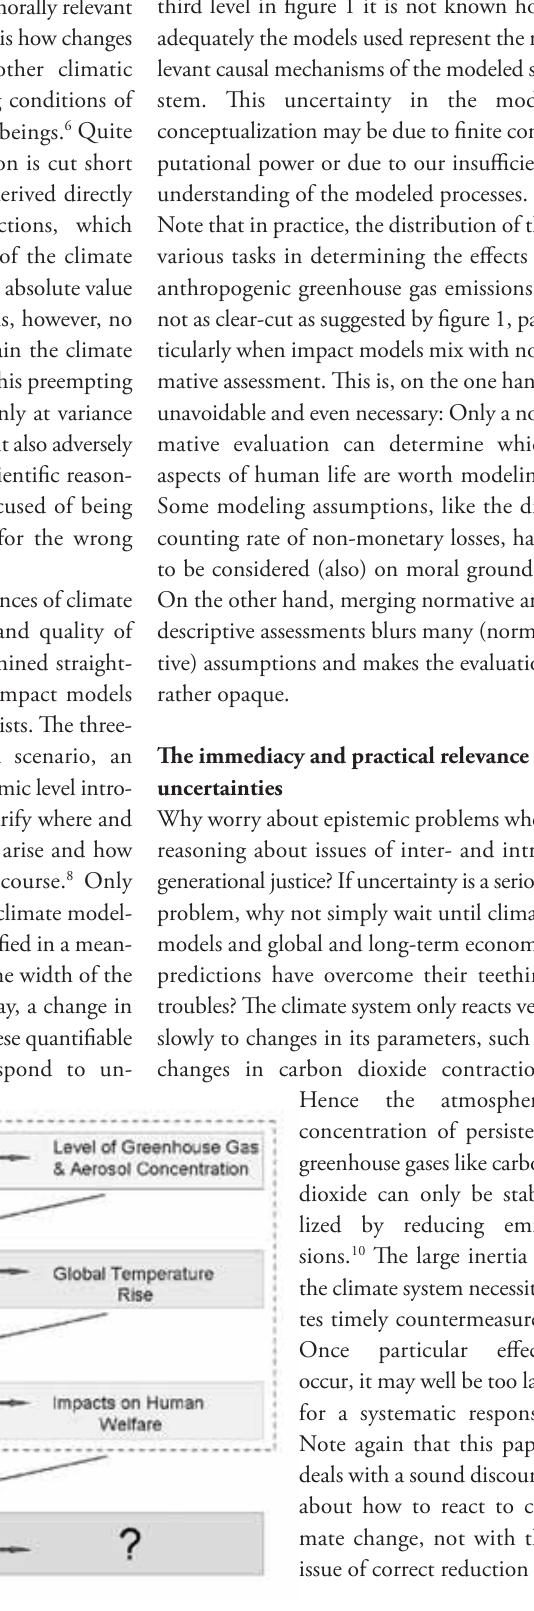
Figure 1: ‘Estimating the impacts of greenhouse gas emissions on human wellbeing.’ Short straight double arrows correspond to 'yields the output', long oblique thick arrows correspond to ‘is input for’. Th e dotted rectangle indicates the combination of scientific prognoses that, as a whole, serve as the empirical input for a political or moral evaluation on the last